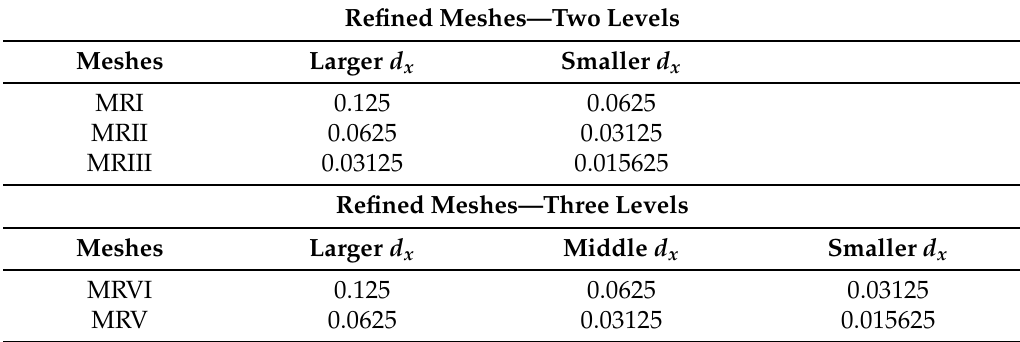
Table 4. Non-uniform meshes used in the 2D planar